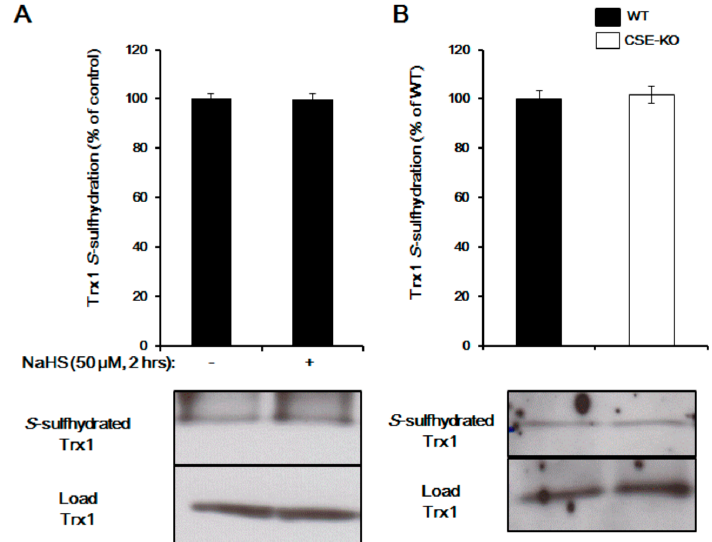
Figure 2. Trx1 is not a target for S -sulfhydration. ( A ) Trx1 S -sulfhdyration was measured in NaHS- treated HepG2 cells (50 µM for 2 h) by biotin switch assay. n = 4. ( B ) Trx1 S -sulfhydration was determined in liver tissues from both wild-type and CSE knockout mice. n = 4. CSE, cystathionine gamma-lyase; KO, knockout; Trx1, thioredoxin 1; WT,